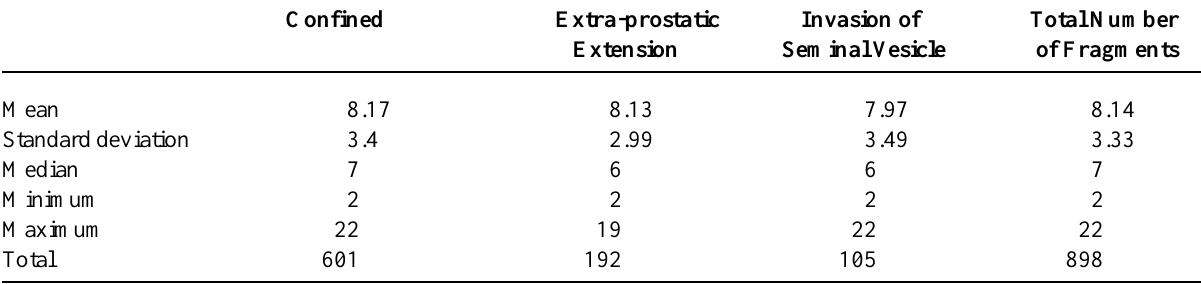
Table 5 – Descriptive measures for total number of collected fragments according to tumor